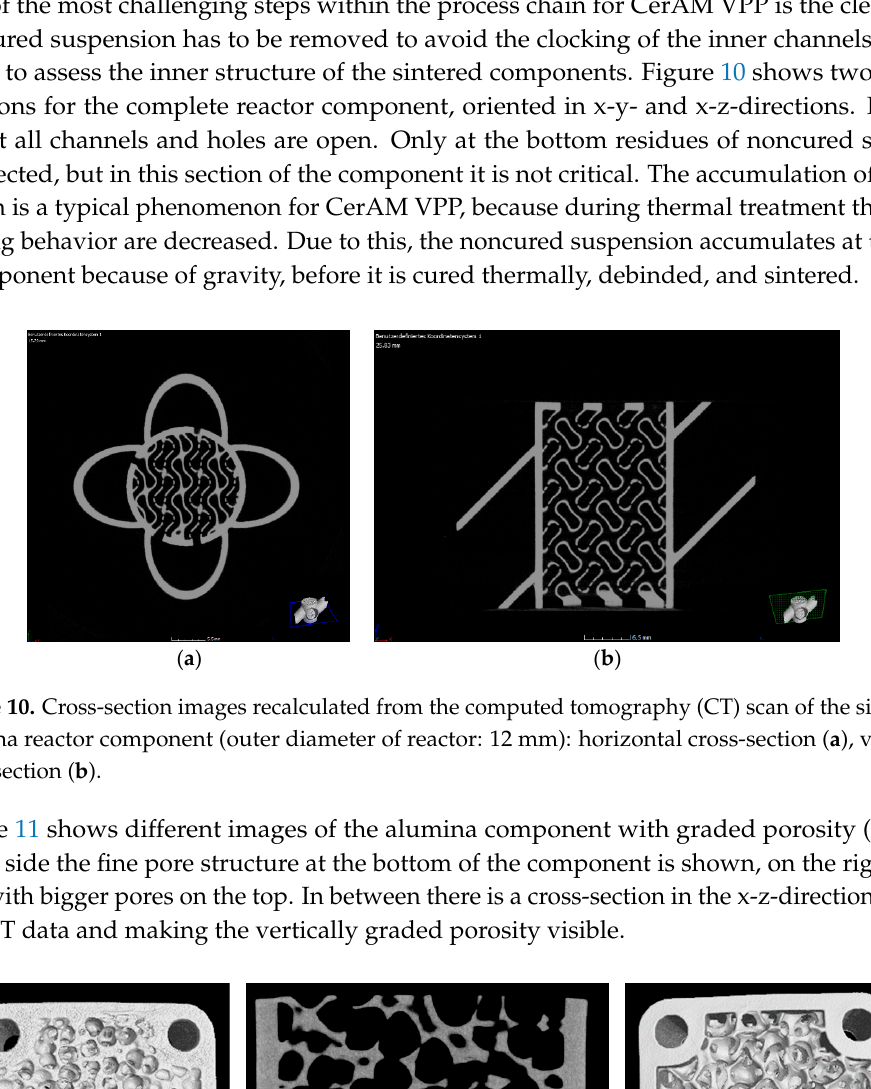
Figure 9. Sintered alumina components manufactured by CerAM VPP: Sliced version of the reactor component ( a ), ceramic component with graded porosity, and pore size distribution inside ( b ).